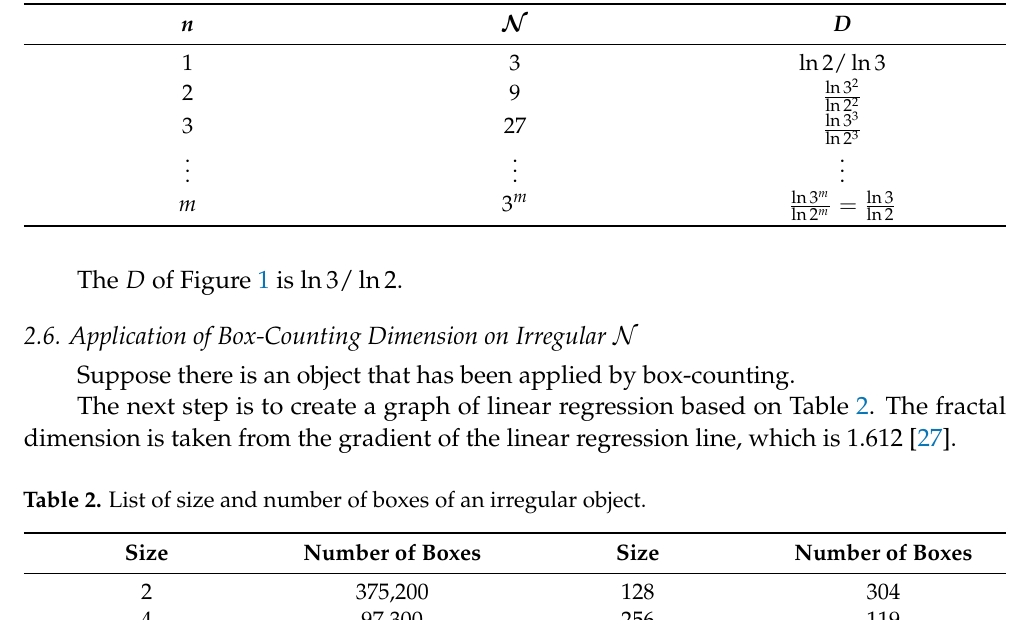
Table 1. List D of Sierpinski Triangle for each n .